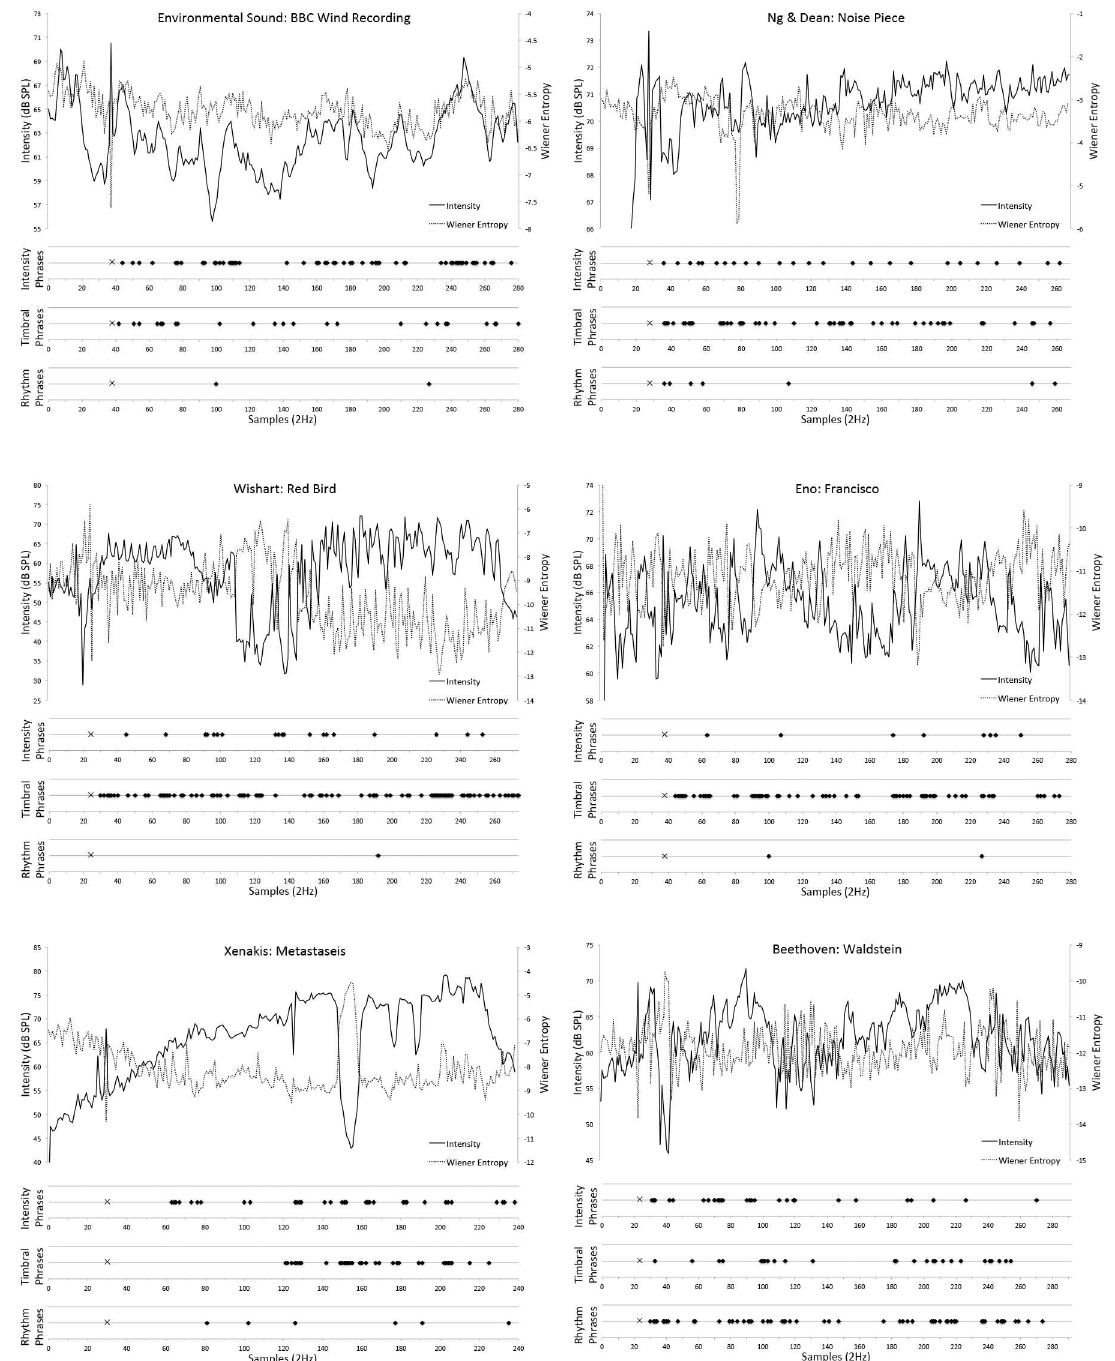
Fig 1. Time-stampedphrase responses and acoustic time-series data. Displays all time-stampedresponses assignedto timbre, intensity, or rhythm categories across the entire time-course of all six stimuli. Acoustic categorieswere basedon thematic analysesof participants’ qualitative descriptions of each perceivedphrase. The diamond-shapedmarkers on the three horizontalscales in each panel signify these data and specifically, the point at which each phrase was perceivedto have ended. The ‘ × ’ symbol signifiesthe moment in each stimulus where a 1kHz pure tone was presented. The pure-toneindicatedto participantsthat they were to begin responding and was used to mark the beginningof the first perceivedphrase. Time-series data of acoustic intensity (solidline; dB SPL on left y-axis) and spectral flatness (dashedline; Wiener entropy on right y-axis) are also plotted for each stimulus. All perceptual and acoustic data are presentedat a samplingrate of